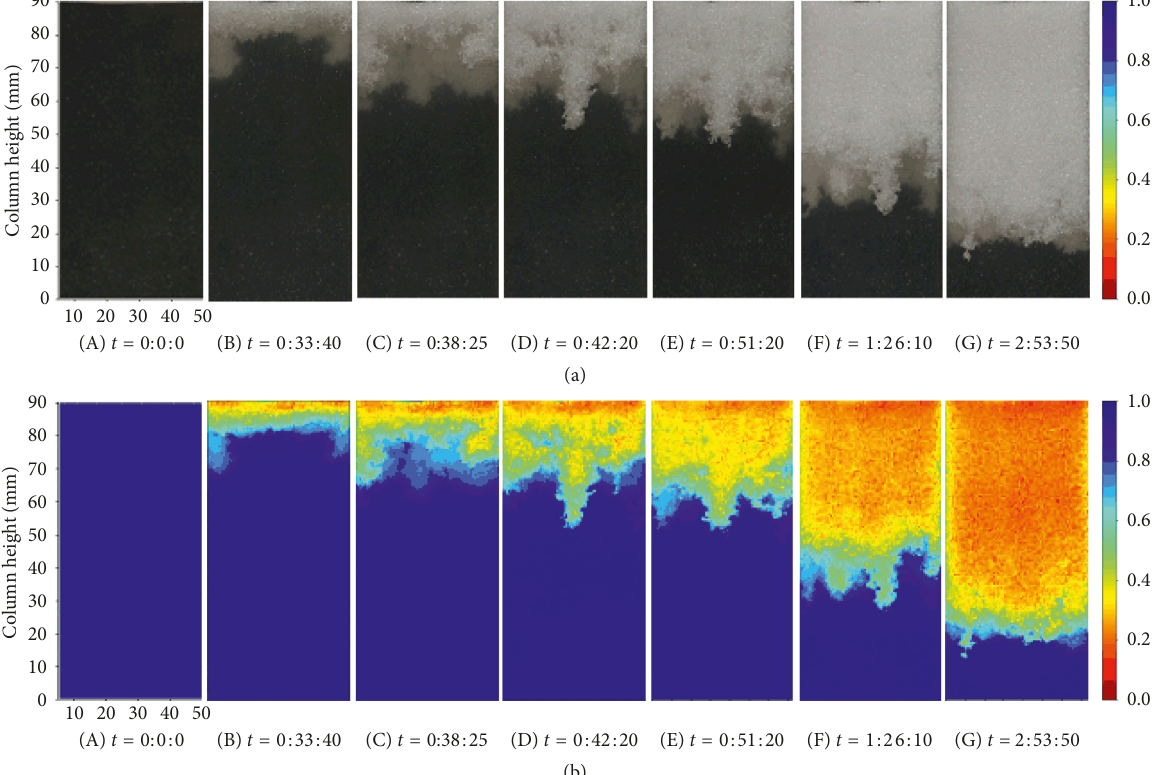
Figure 7: Visualization of the fingering phenomena at the air front through partially saturated transparent soil at different drainage stages: (a) original digital photographs and (b) moisture maps from photometric